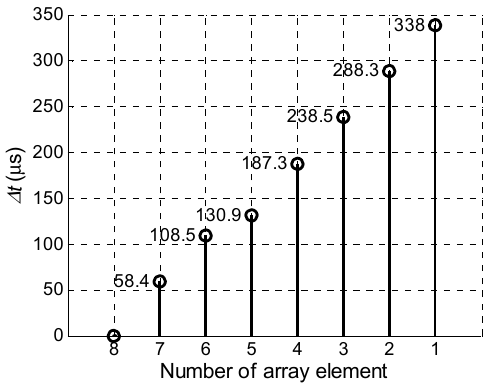
Figure 19. Optimised delay scheme of the array excitation signals.